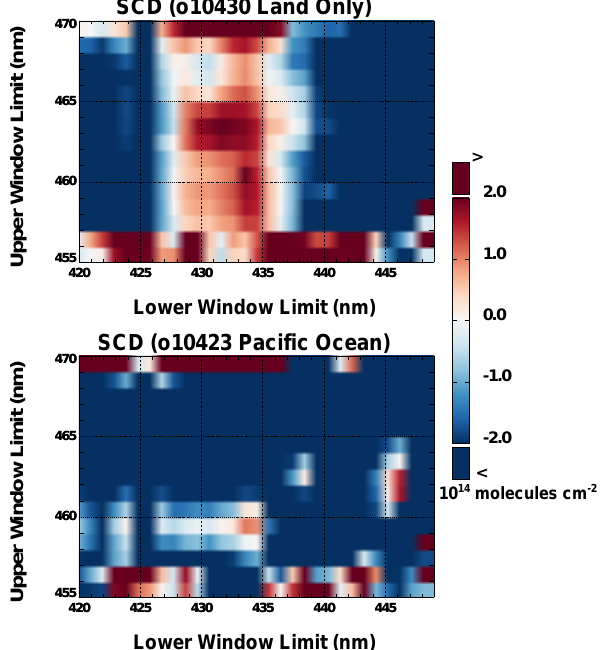
Figure 11. Mean glyoxal Slant column density retrieved as a func- tion of window limits. Top: mean SCD retrieved for all retrievals over land from o10430. Bottom: mean SCD retrieved from 0 to 30 ◦ N over the Pacific Ocean (o10423).